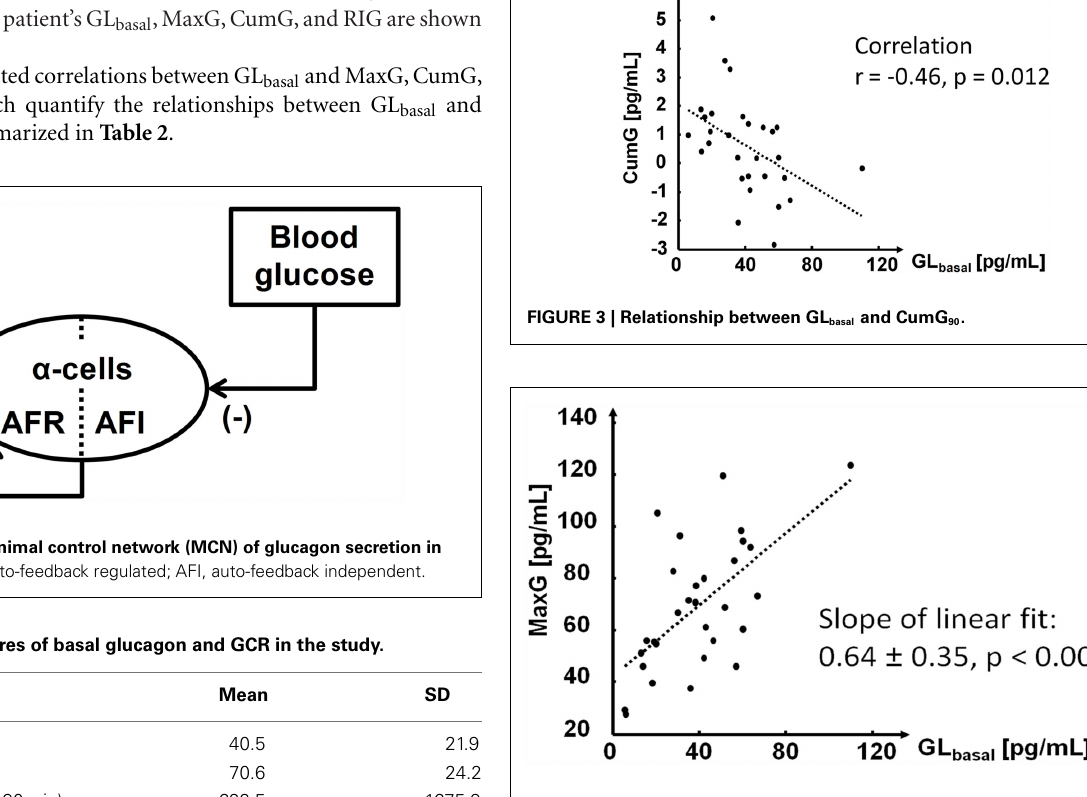
FIGURE 4 | Relationship between GL basal and